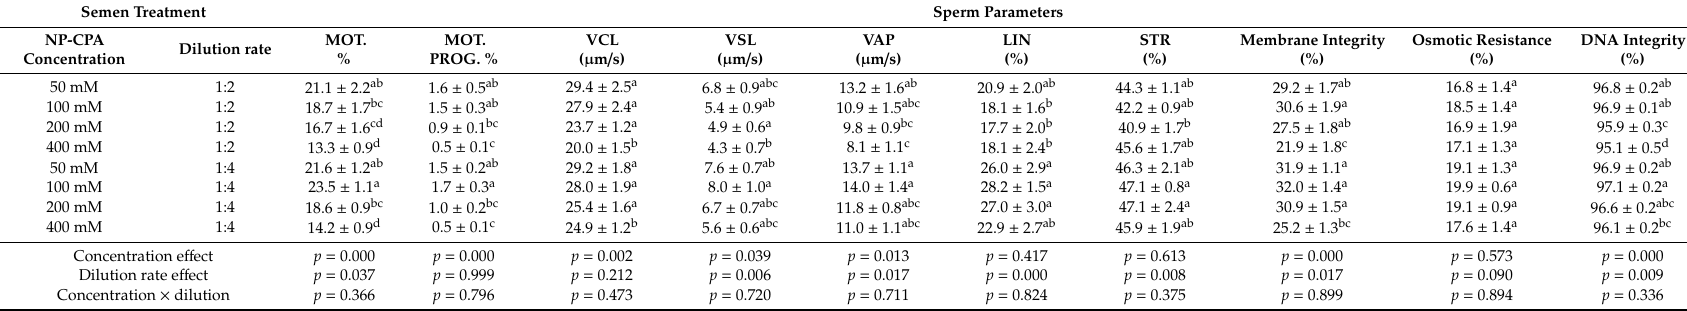
Table 5. Sperm quality parameters (mean ± S.E.M.) outcomes in turkey semen frozen with trehalose considering di ff erent concentrations and two dilution rates (N = 8). Semen Treatment Sperm Parameters NP-CPA Concentration